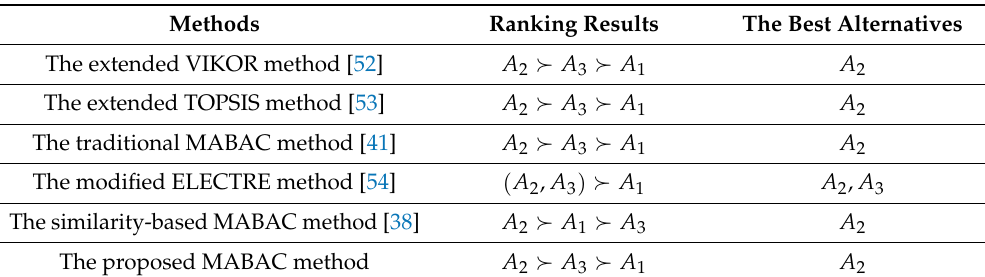
Table 7. Ranking results according to six methods.